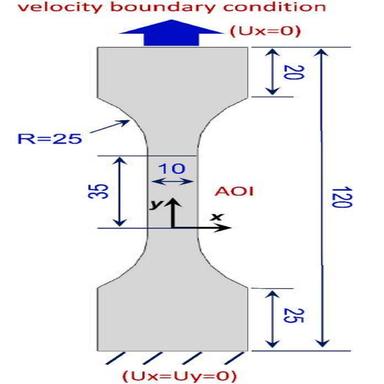
The FE model for the IFHS test simulations (unit: mm).